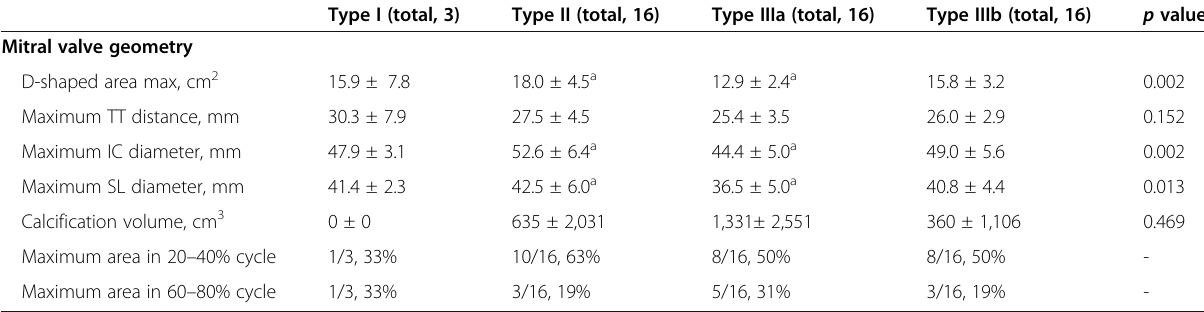
Table 3 Mitral annular dimensions in the different types of MR based on Carpentier ’ s classification Type I (total,